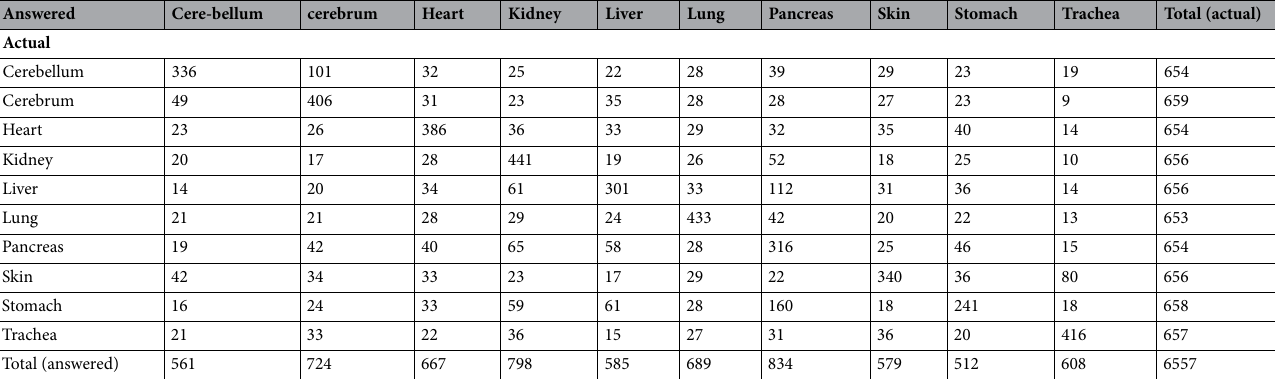
Table 8. Confusion matrix of the aggregated responses from 66 medical students (MS) over quiz questionnaire ( n = 6557).